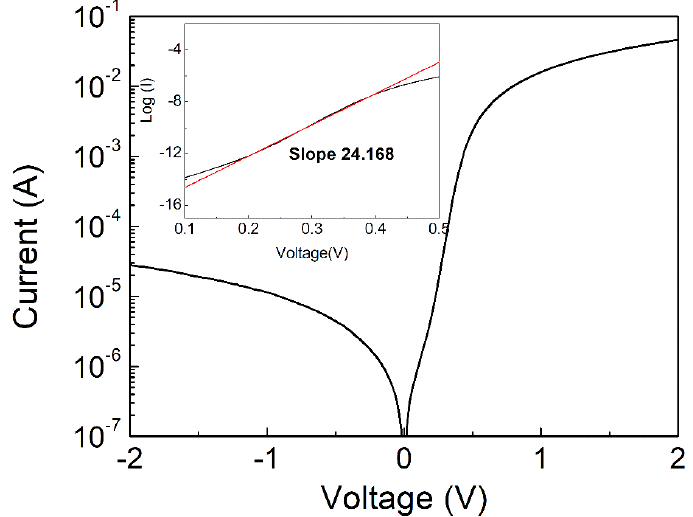
Figure 2. (Color Online) I–V characteristics of the Pd / ZnO SBDs from -3 to 2 V at room temperature. Ideality factor (n) is shown in the inset.